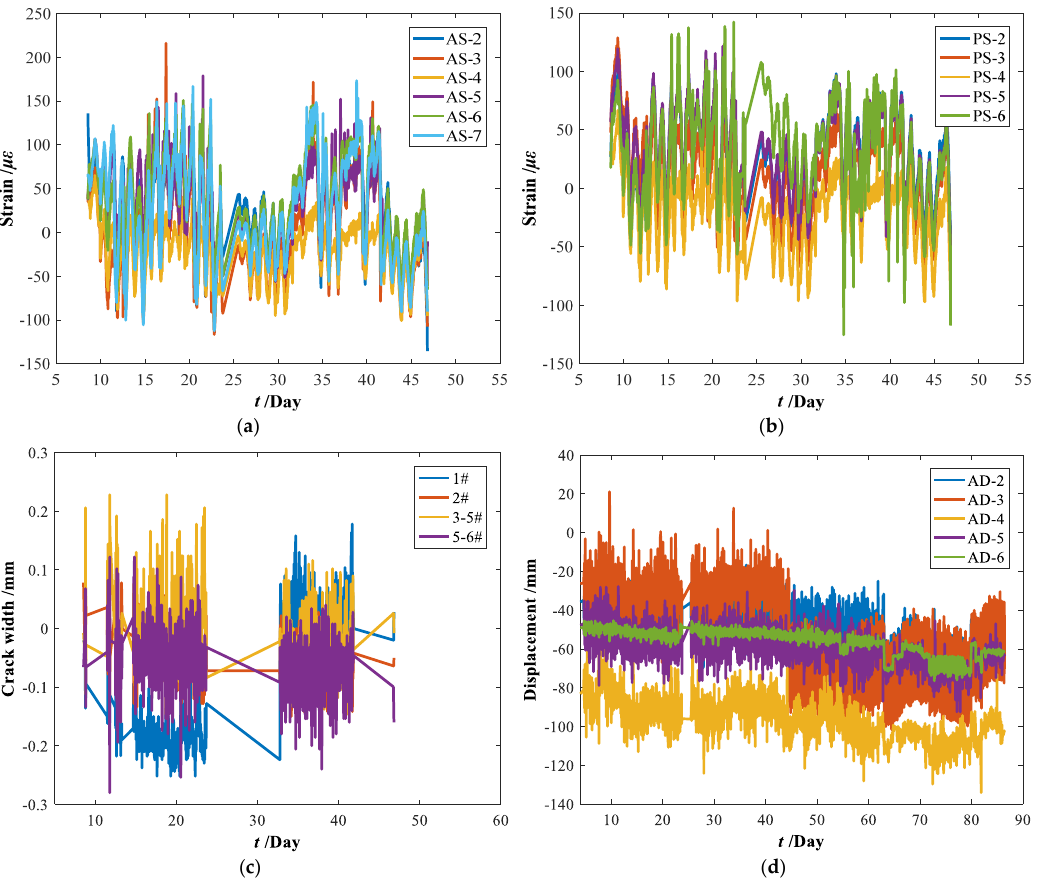
Figure 10. Measuring datasets of the bridge case considering eliminating temperature effect. ( a ) Strains of arch ribs. ( b ) Strains of pier column ends. ( c ) Crack widths of deck beams. ( d ) Displacements of arch ribs.